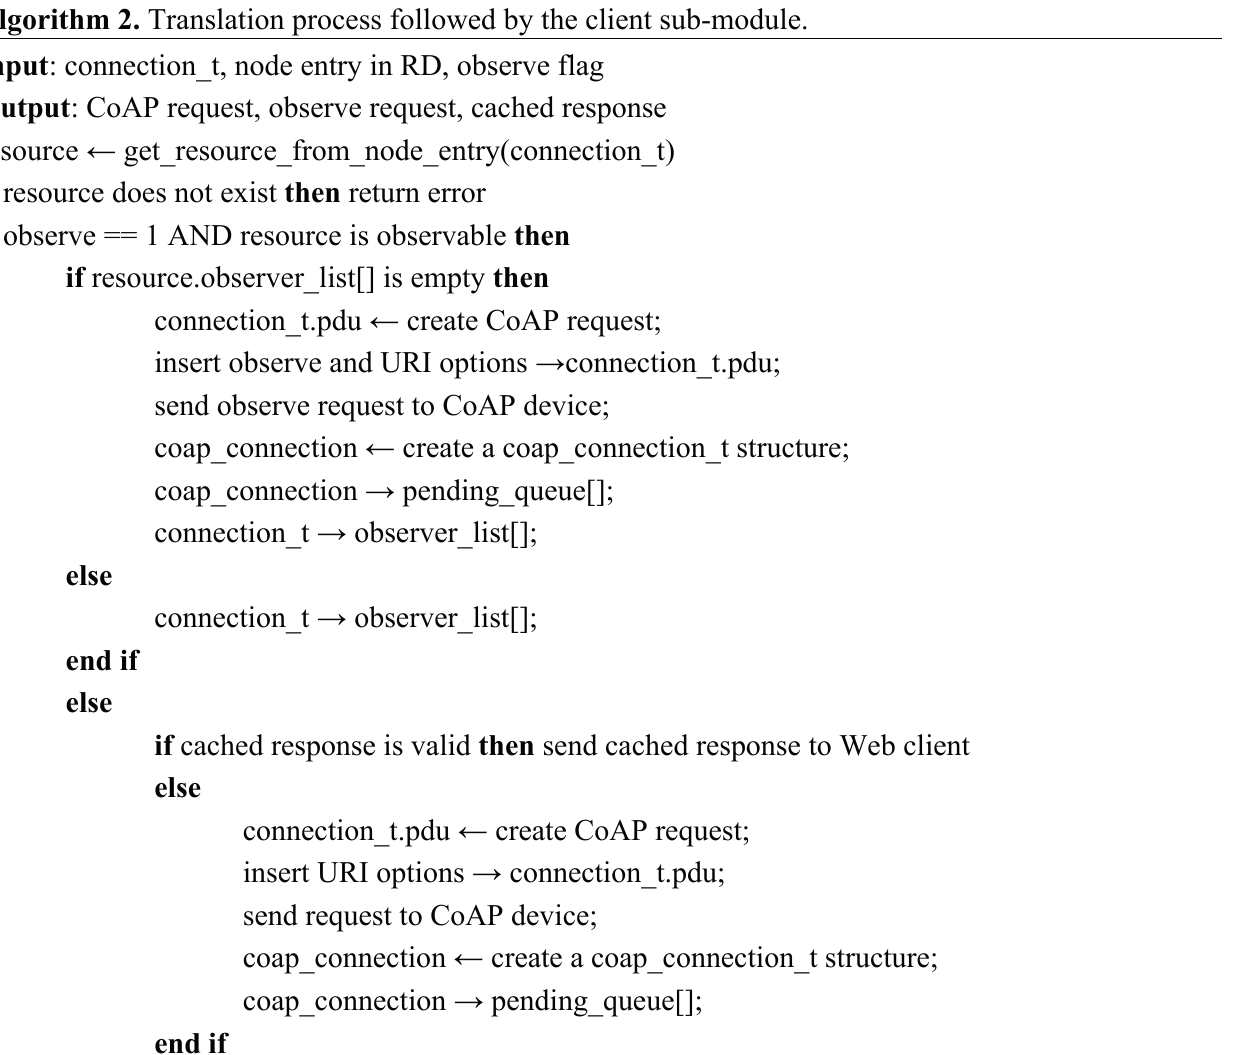
Algorithm 2. Translation process followed by the client